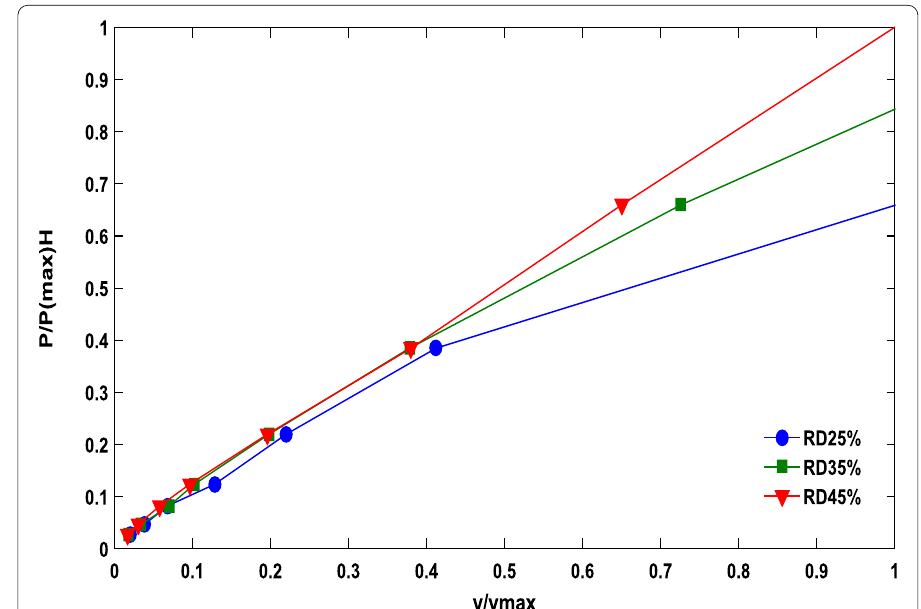
Fig. 10 Comparison of normalized lateral load versus normalized displacement for the pile embedded in horizontal ground